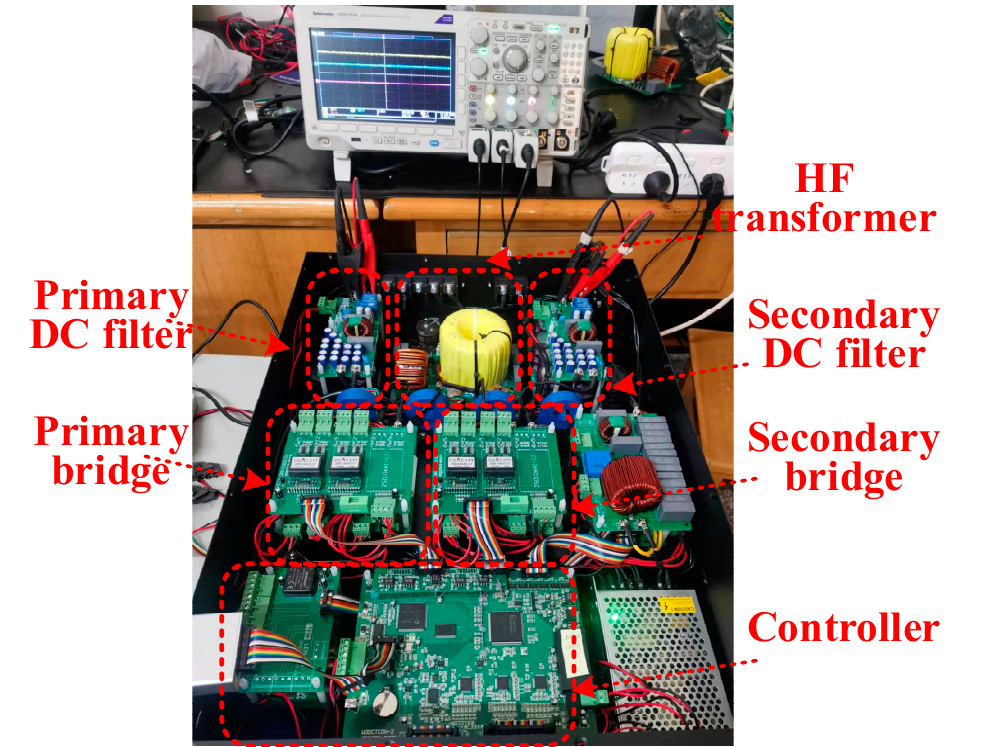
Figure 7. The DAB converter prototype.